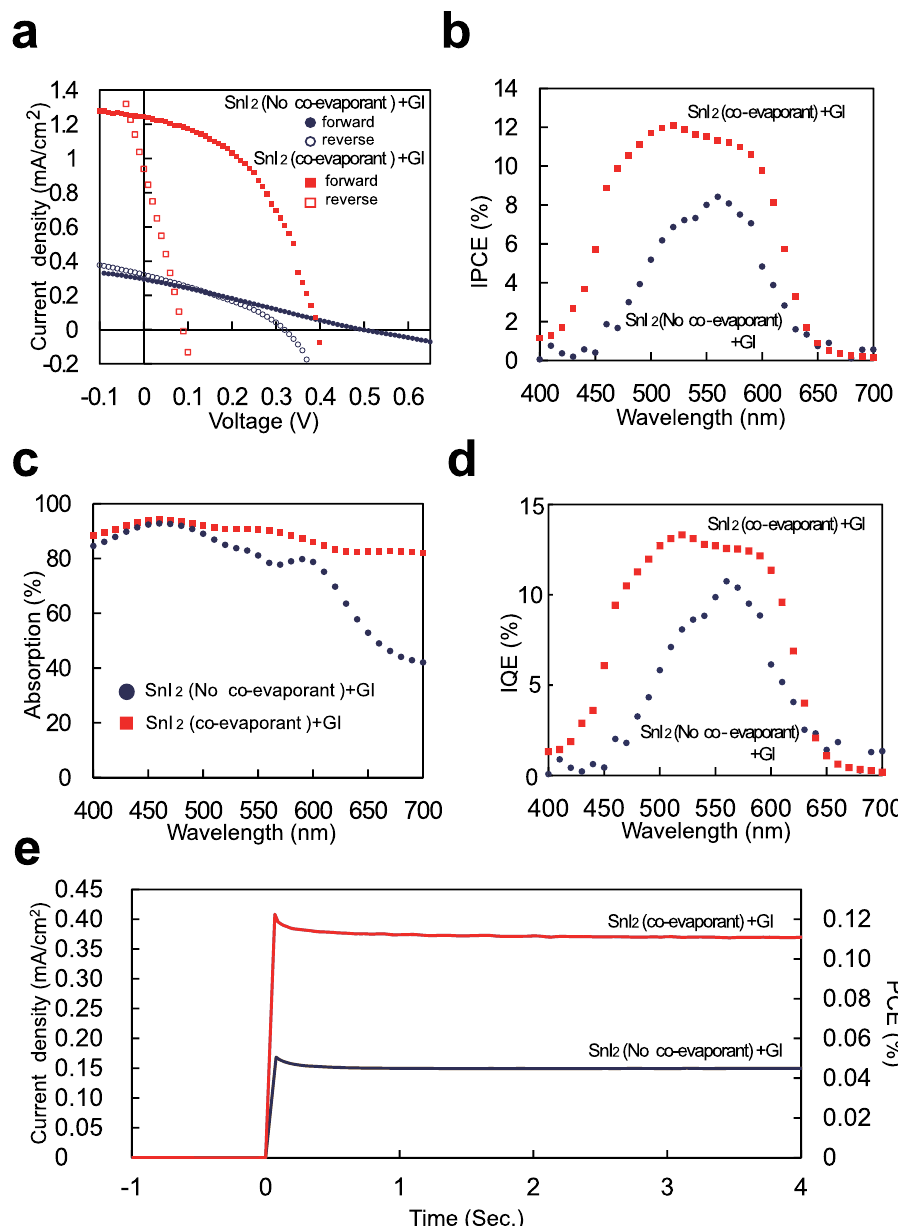
Figure 3. Performance improvements of SnI 2 + GI solar cells by co-evaporant induced crystallization. ( a ) J - V curve of 1 cm 2 cell, ( b ) IPCE, ( c ) absorption spectra, ( d ) IQE, and ( e ) stabilized power output under bias application of 0.30